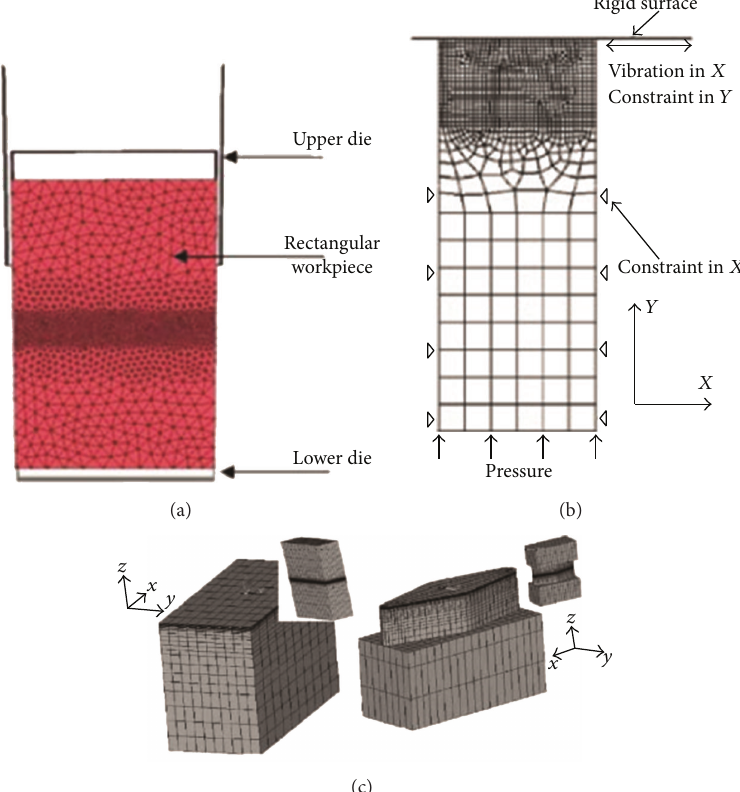
Figure 2: Diagrams showing the meshing used typically for a 2D testpiece LFW process model in various LFW FE simulations: (a) 2D simulation of both sides of the joint, (b) 2D simulation of 1 side of the joint, and (c) 3D simulation. 𝑇 𝐴 , 𝐵 , 𝐶 , 𝑚 , and 𝑛 𝑚 is a melting temperature, and